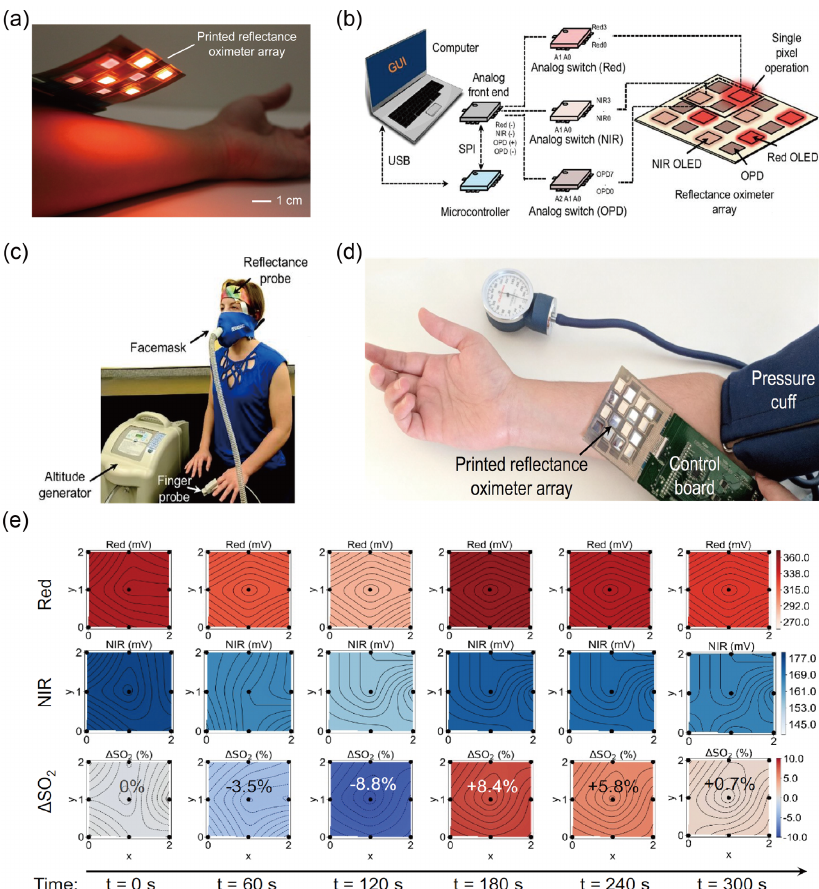
Figure 12. ( a ) Image of the reflectance oximeter array (ROA) applied to the human forearm. ( b ) Schematic of the reflectance oximeter system. ( c ) Setup for changing the human subject’s oxygen saturation. The subject breathes through a face mask, and the oxygen content is changed using an altitude simulator. SpO2 was measured with a conventional probe on the finger and a reflectance oximeter on the forehead. ( d ) Setup to measure oxygen saturation changes in the forearm using ROA. The pressure cuff controls the blood supply to the forearm. The ROA provides 3 × 3 oximeter pixels in a 4 × 4 device. ( e ) Two-dimensional contour maps showing red, NIR, and ∆ SO2; normal condition (t = 0 s), ischemia condition (t = 60, 120 s), and after releasing the pressure cuff (t = 180, 240, 300 s). Adapted with permission from [38], AAAS,